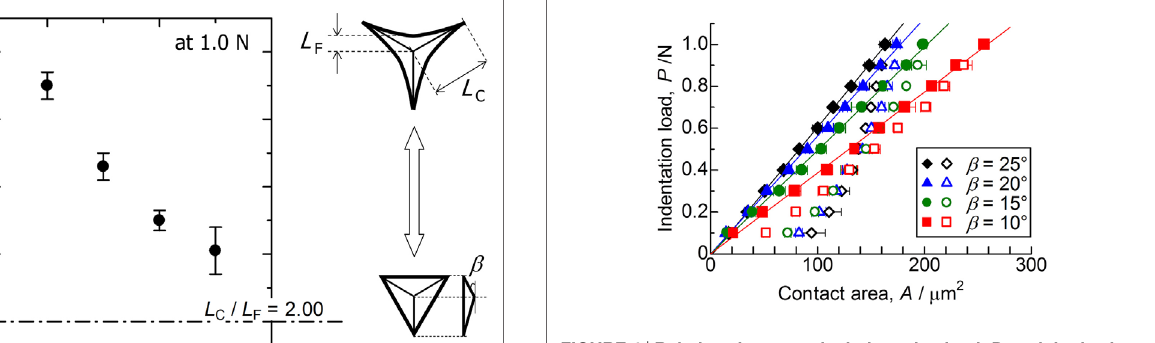
TaBle 1 | some parameters obtained from in situ contact areas and from fringe patterns around indentation periphery.